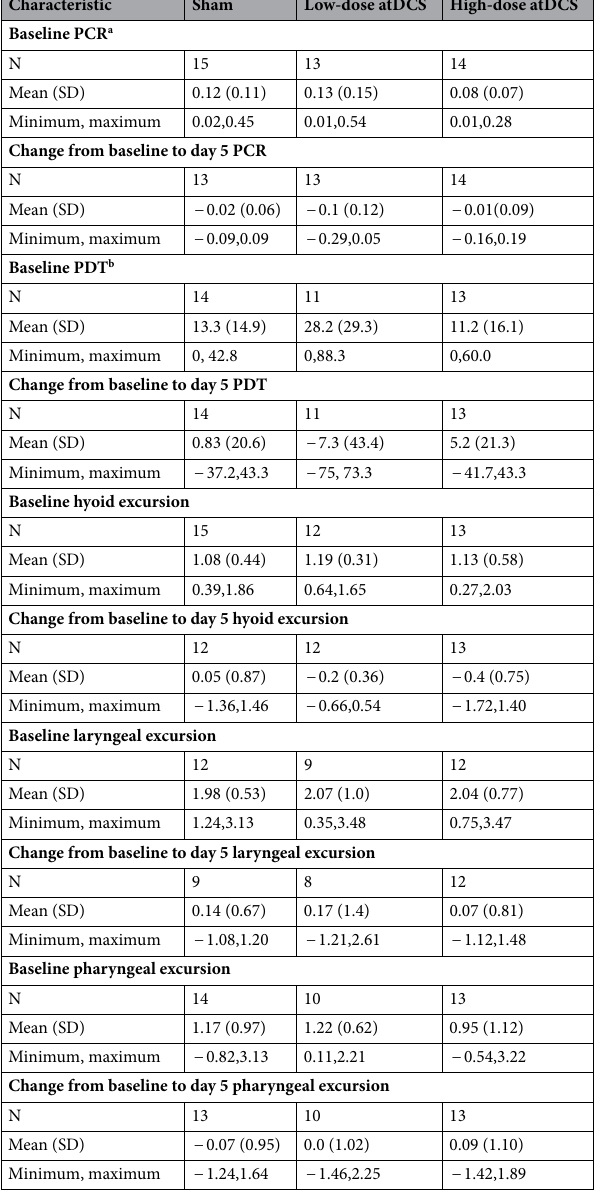
Table 5. Swallowing physiology outcomes across sham and anodal transcranial direct stimulation (atDCS) groups. a Pharyngeal Constriction Ratio. b Pharyngeal Delay Time.